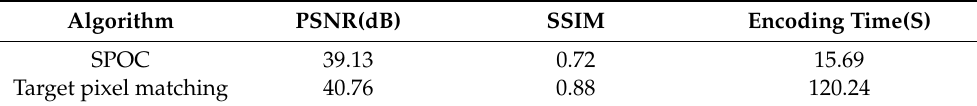
Table 2. Comparison of PSNR and SSIM of the two algorithms in case